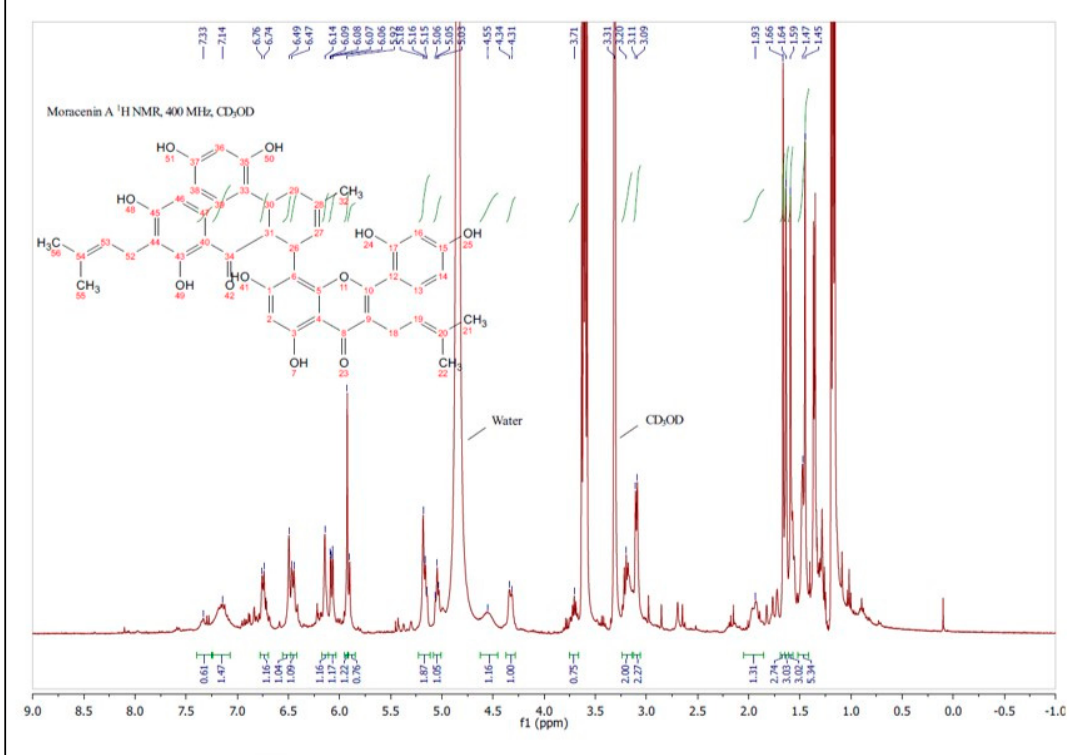
Figure A3. 1 H-NMR (400 MHz, CD 3 OD) spectrum of the compound Moracenin A.